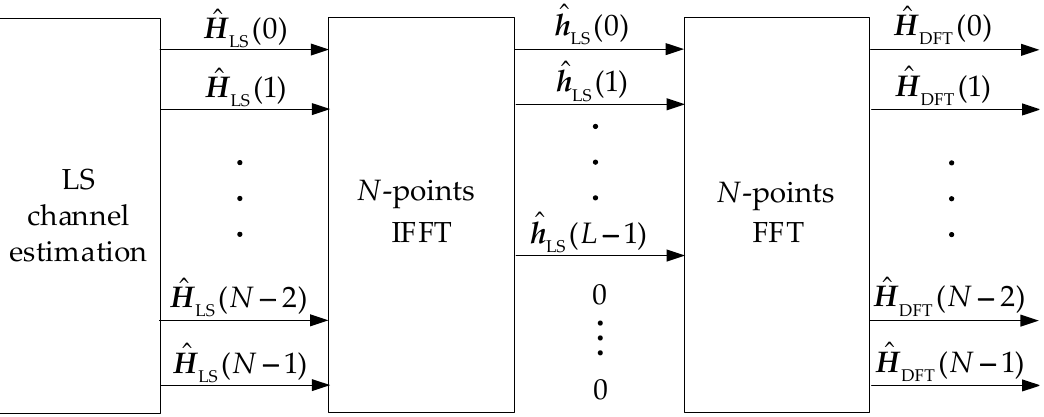
Figure 2. Discrete Fourier transform (DFT) channel estimation method in cyclic prefix (CP)-OFDM system.